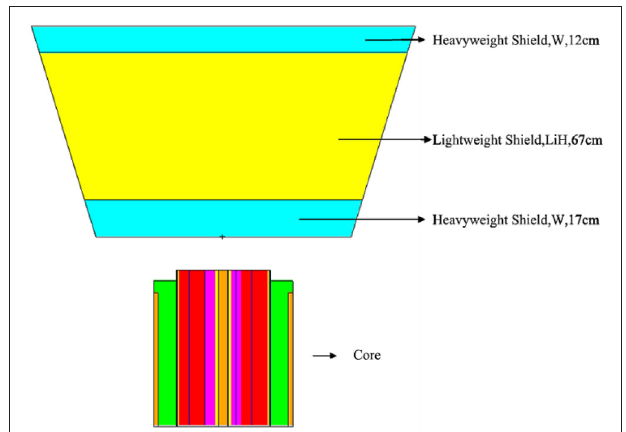
FIGURE 4 | Shielding